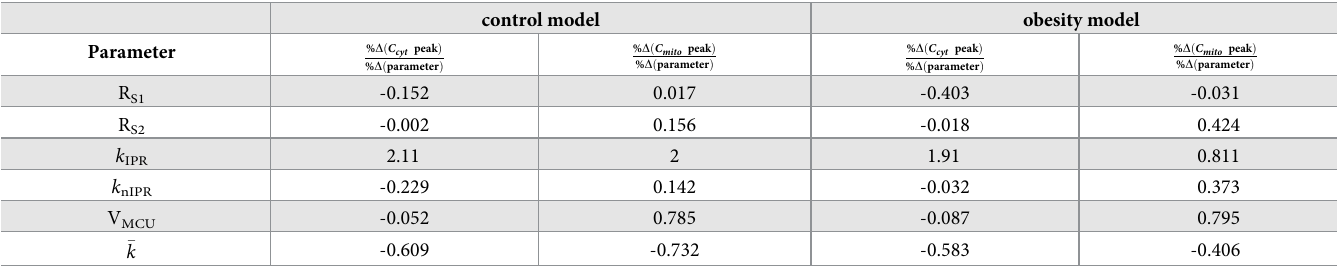
and C peaks to a small change in each cyt mito